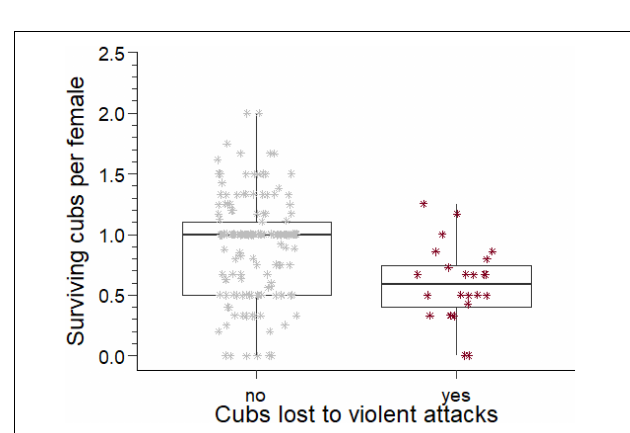
FIGURE 3 | The number of cubs produced per mother by males who lost cubs to violent attack and those who did not. The box comprises the interquartile range, the horizontal line is the median, the whiskers cover the range of values 1.5 times the value of the interquartile